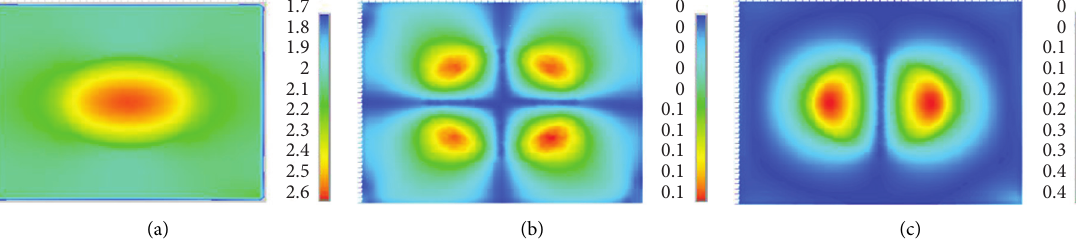
� 500m/s). Top view displacement cloud s